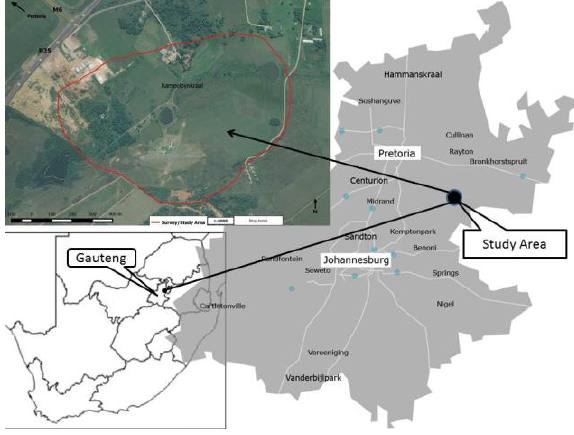
Figure 1. The Cors-Air study area to the east of Pretoria, Gauteng Province.